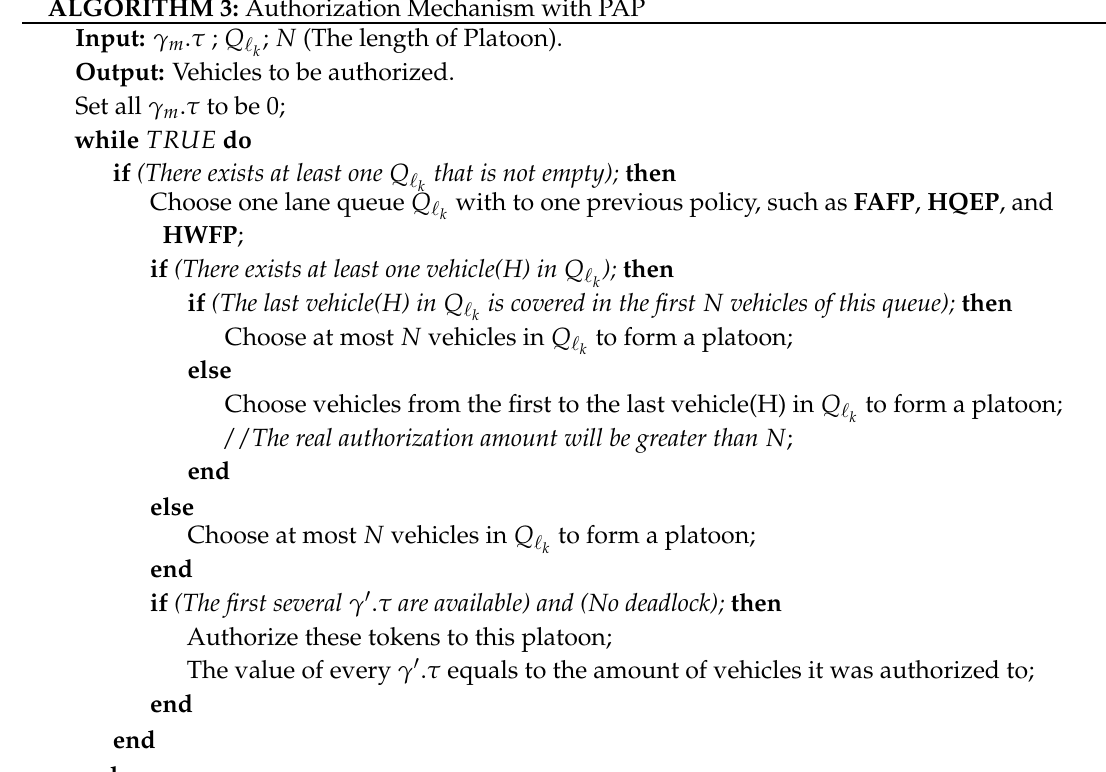
ALGORITHM 3: Authorization Mechanism with